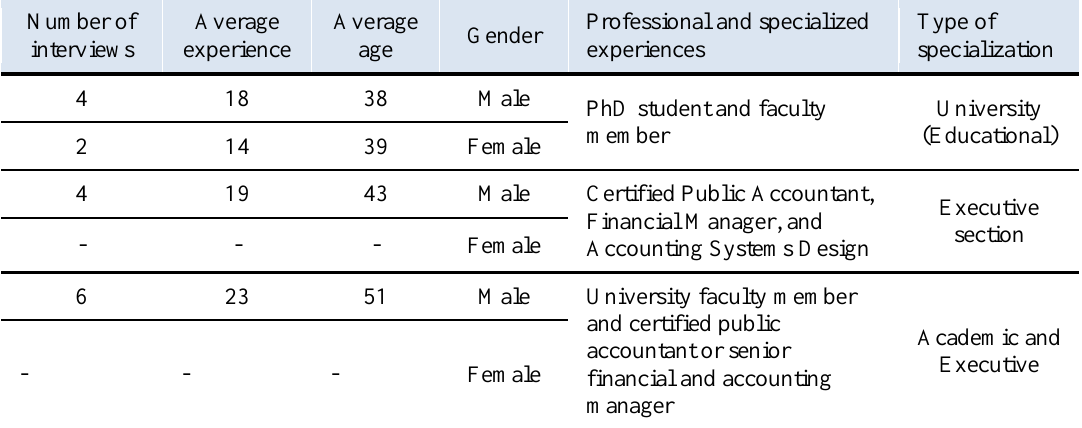
Table 1. The demographic information of the interviewees (experts) of the